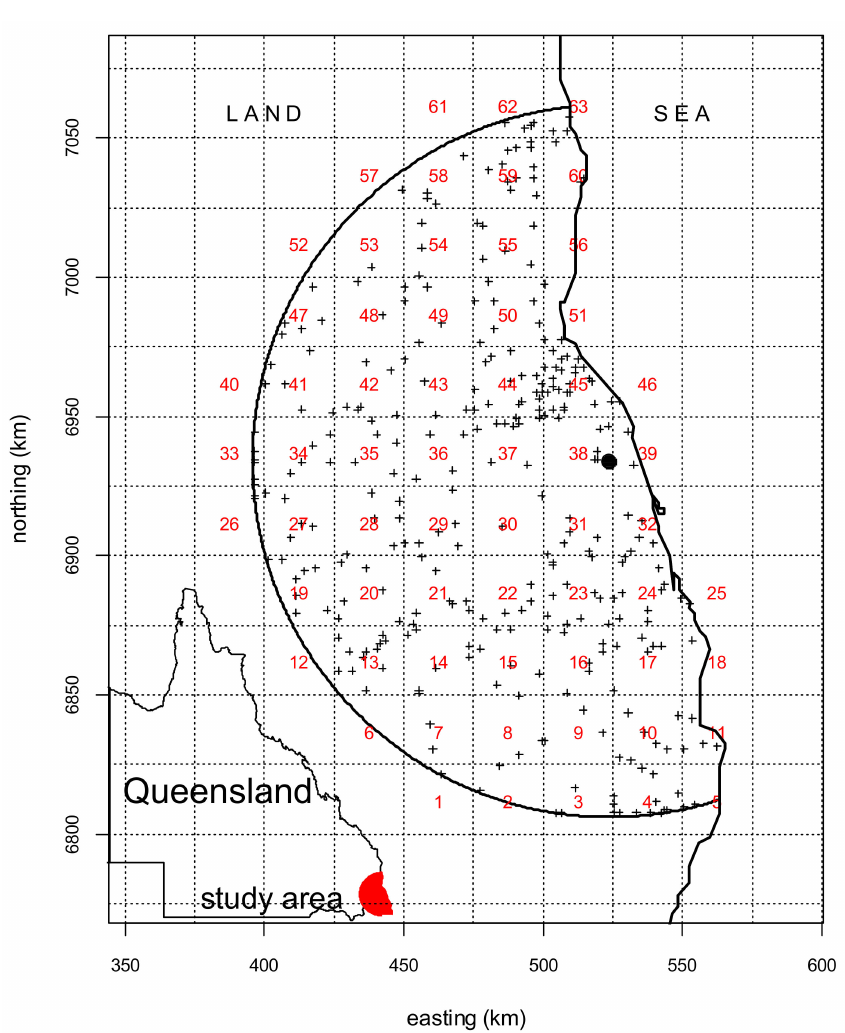
Figure 1. The study area: pluses are the location of the rain gauges, solid circle is the location of the Staplyton radar, and the numbers are the 25 km × 25 km grid